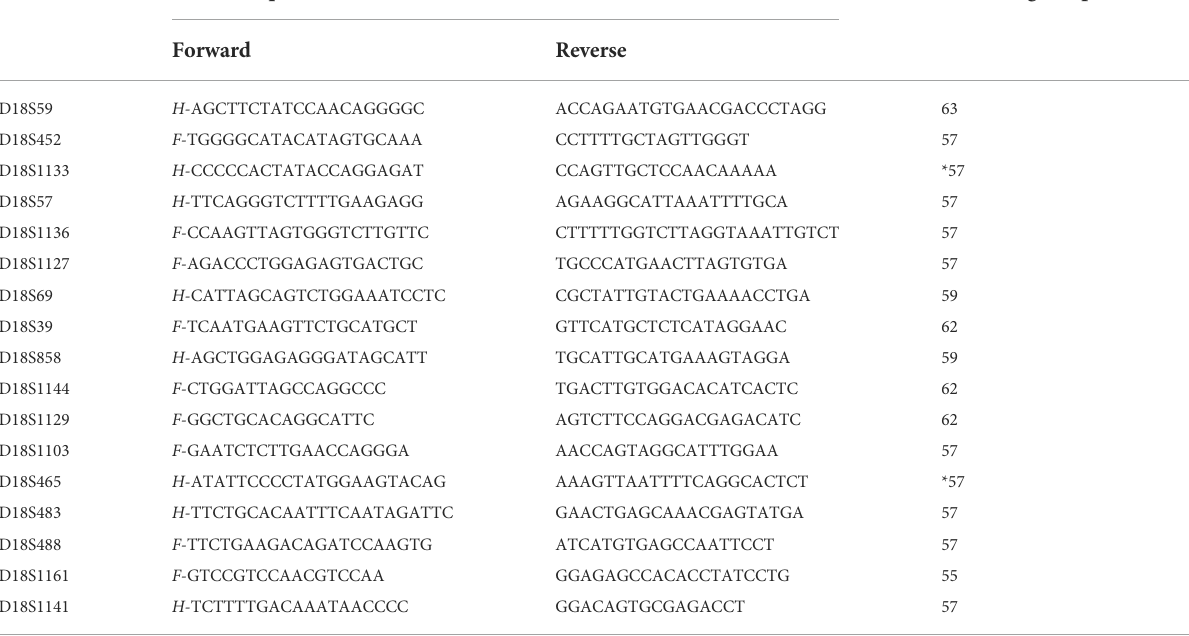
TABLE 1 Primer sequences and annealing temperatures used to amplify microsatellite markers of chromosome 18. Marker